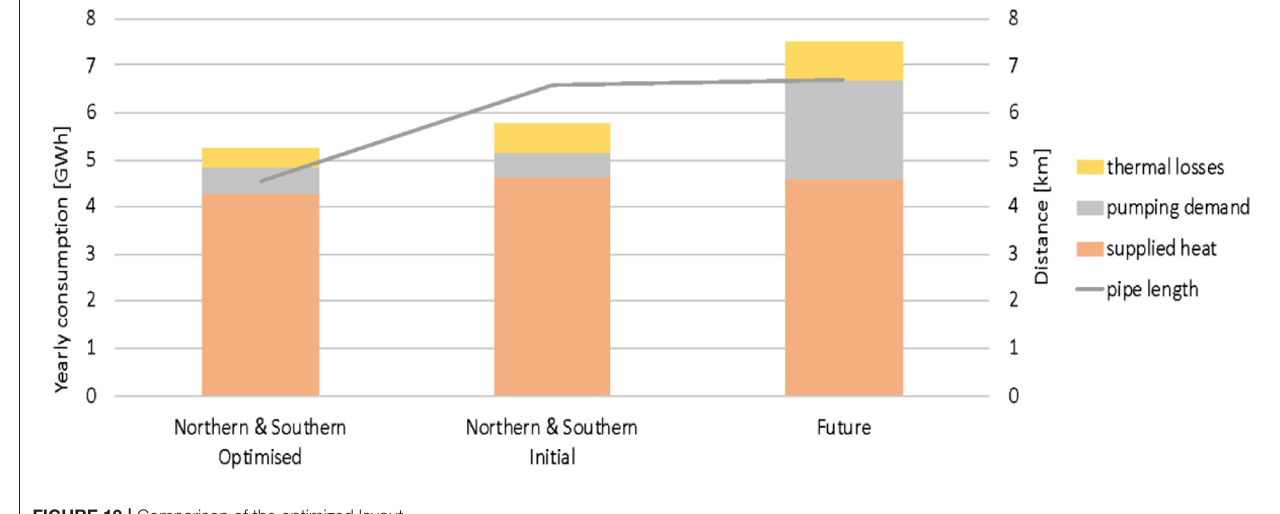
FIGURE 10 | Comparison of the optimized layout.